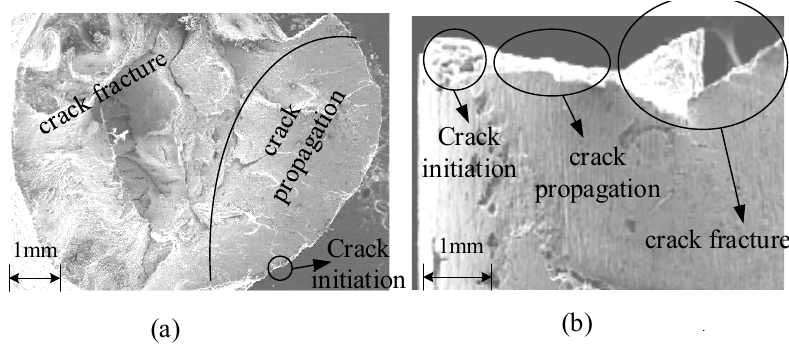
Figure 1. Area diagram of corroded steel wire.